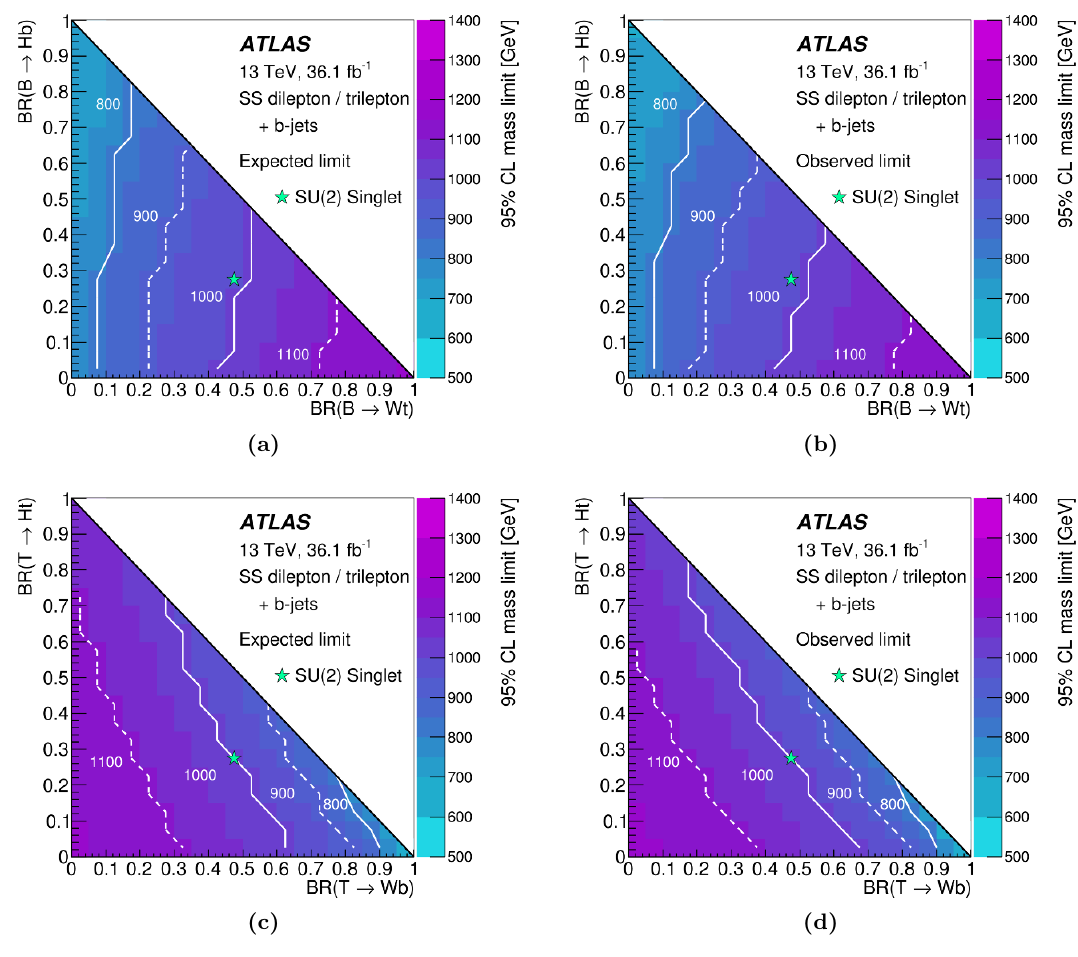
Figure 9 . Mass hypotheses excluded at 95% CL as a function of the branching ratio: (a) expected and (b) observed limits for a vector-like B -quark, (c) expected and (d) observed limits for a vector- like T -quark. Contours of constant 95% CL lower mass limits are shown in white in each plot, and labelled with the mass limit in GeV. The star represents the branching ratios for the SU(2) singlet models of ref. [2].